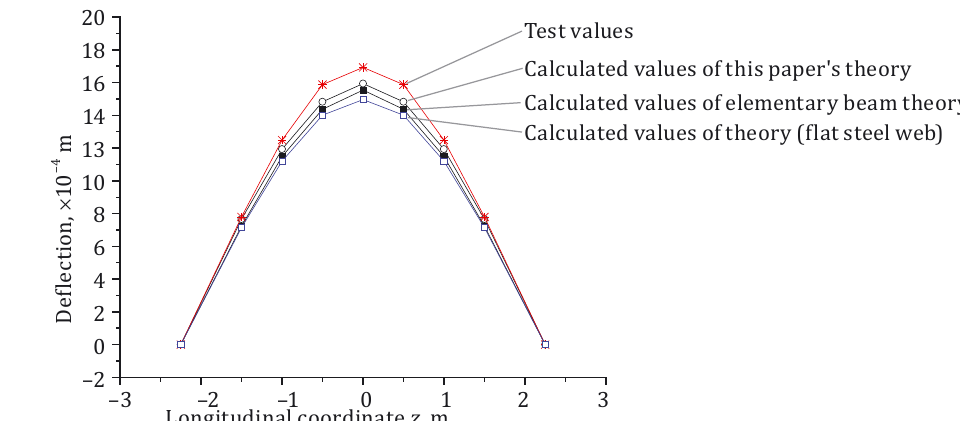
Finite element value under concentrated load Theoretical value of this paper under concentrated